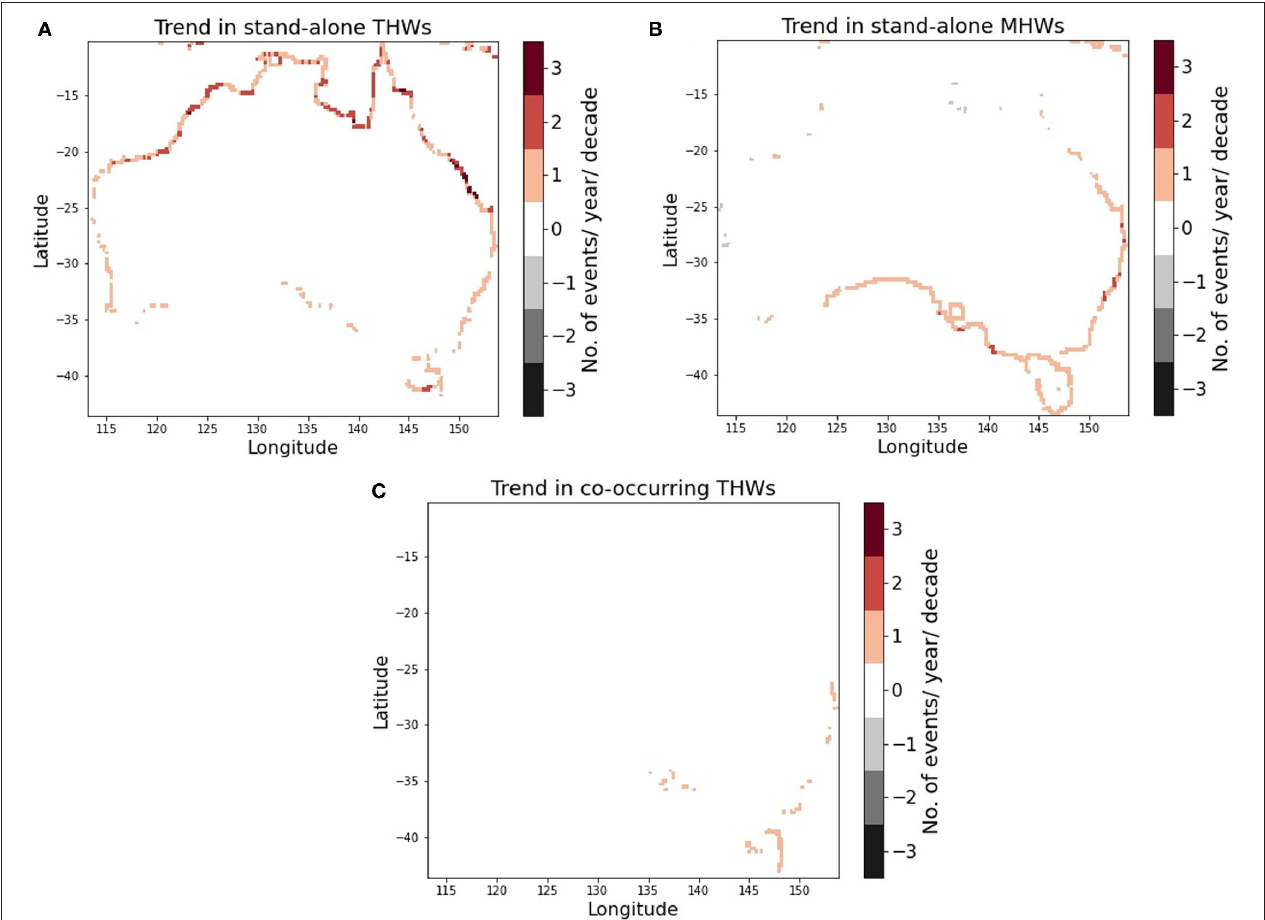
FIGURE 4 | Trend in the number of events per year per decade of (A) terrestrial heatwaves, (B) marine heatwaves and (C) co-occurring events along the coastal belt of Australia. The trends were calculated for pairs of adjacent cells 0.5 ◦ inland for all events from 1982 to 2018. Trends are computed by Sen’s Kendall slope estimator, which is nonparametric and is robust against outliers and data that is not normally distributed ( Sen, 1986). Trends are only shown where they are statistically significant at the 5%